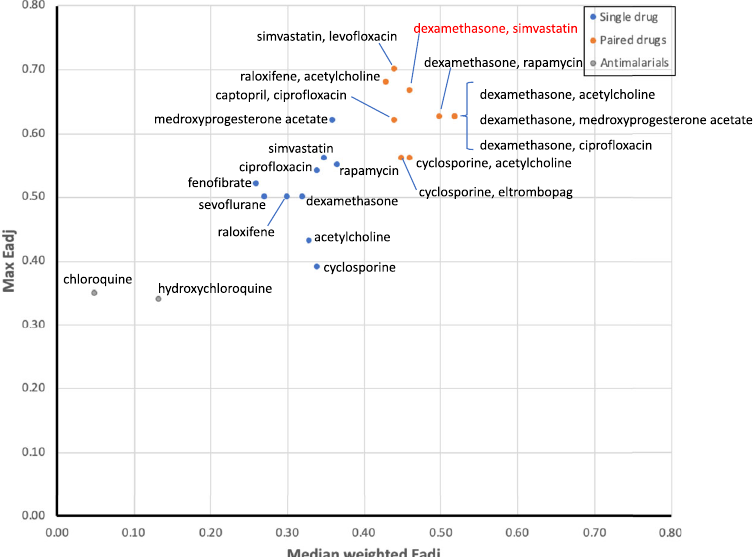
Fig. 5 Broad vs focused performance. Maximum adjusted enrichment (max E adj ) obtained for any single idealized intervention (MIS) versus the aggregate performance expressed as the weighted median adjusted enrichment (WM E adj ) across all 16 signi fi cantly actionable MIS solutions for the top ten ranked single drugs (blue dots) and drug pairs (orange dots) (Additional File 1, Supplementary Tables 2 and